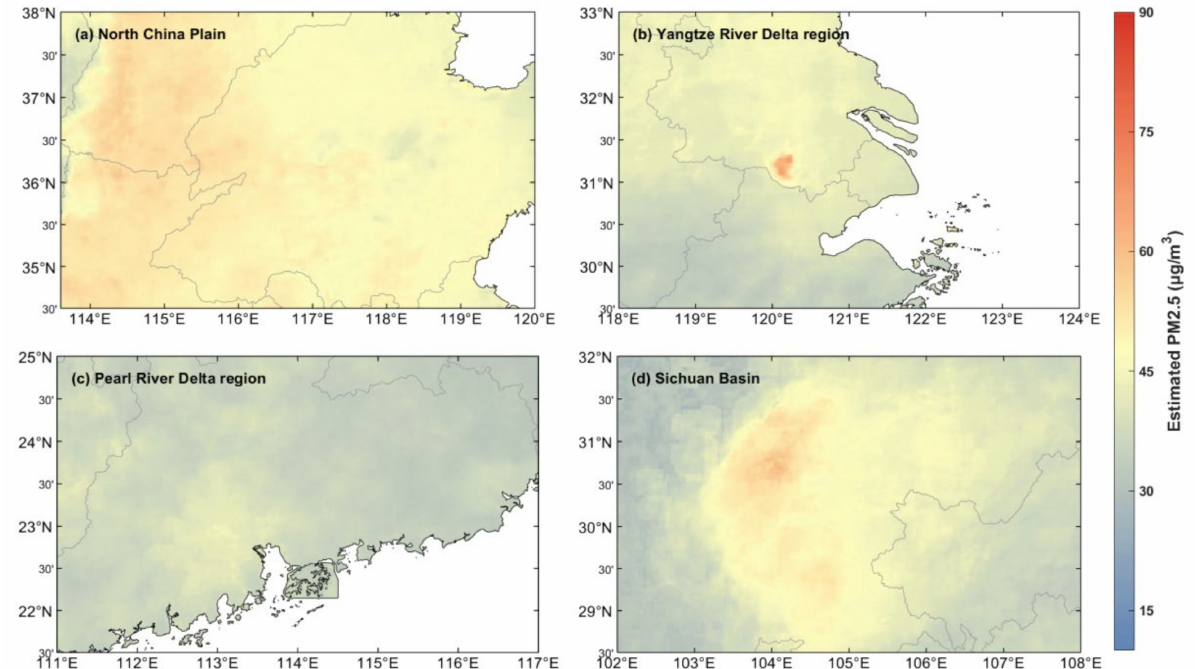
Figure 9. Annual averaged surface PM 2.5 levels in 2018 for four typical polluted regions: ( a ) North China Plain, ( b ) Yangtze River Delta region, ( c ) Pearl River Delta region, and ( d ) Sichuan